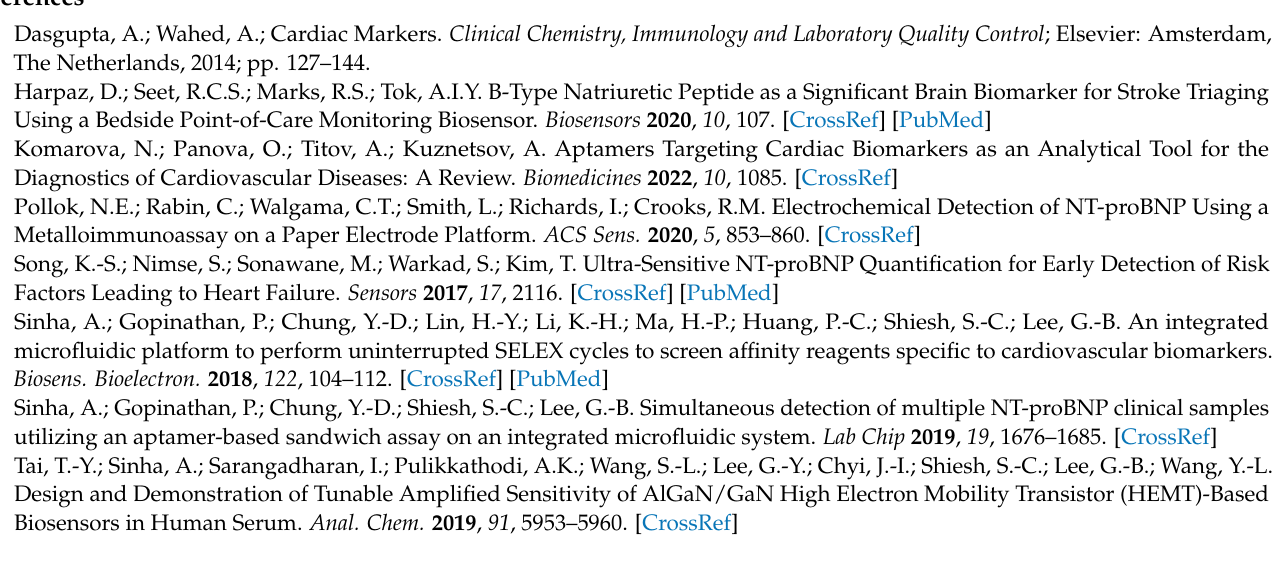
PBS; Figure S2: Energy-dispersive spectroscopy characterization; Figure S3: Control experiments on selectivity and specificity; Figure S4: Calculation of LOD for GFET sensor, modified by